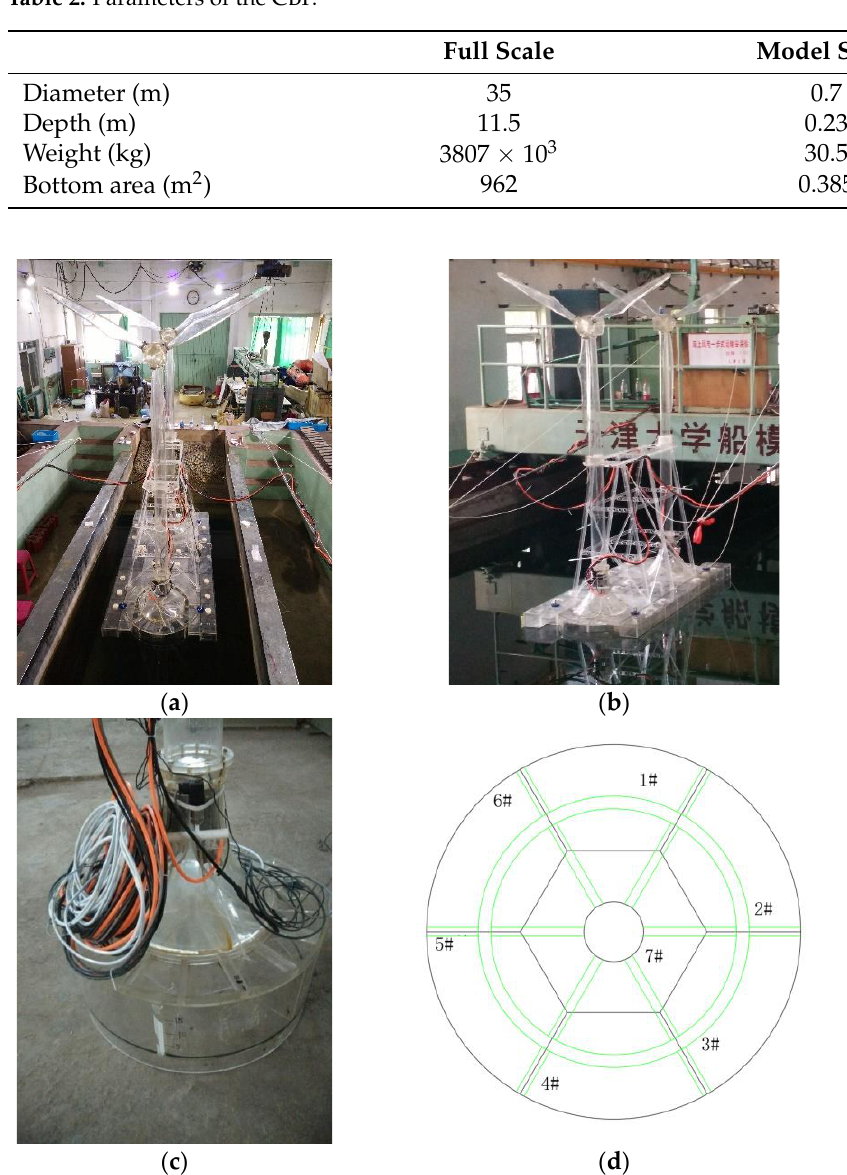
Table 2. Parameters of the CBF.